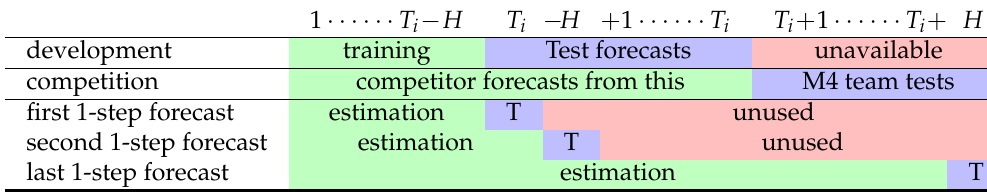
Table 5. Data use in developing, evaluating and forecasting for our M4 submission.